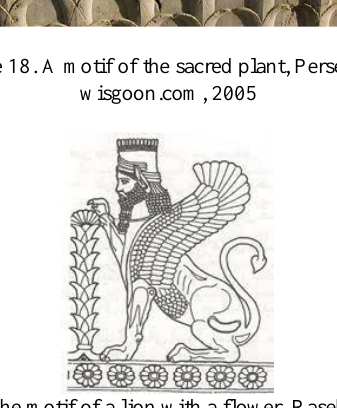
Figure 19. The motif of a lion with a flower, Rasekhoon, 2013